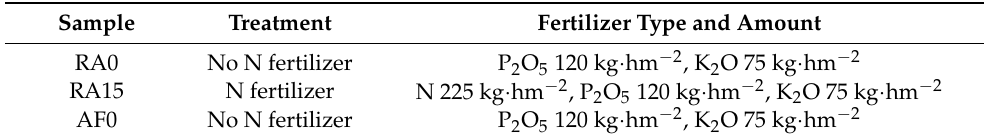
Table 1. Fertilizer type and amount of different treatments.